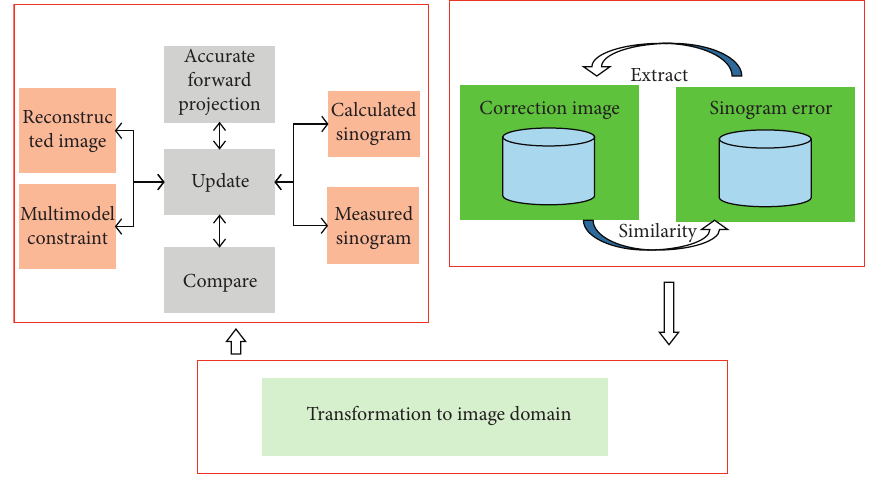
Figure 4: D learning law system structure.